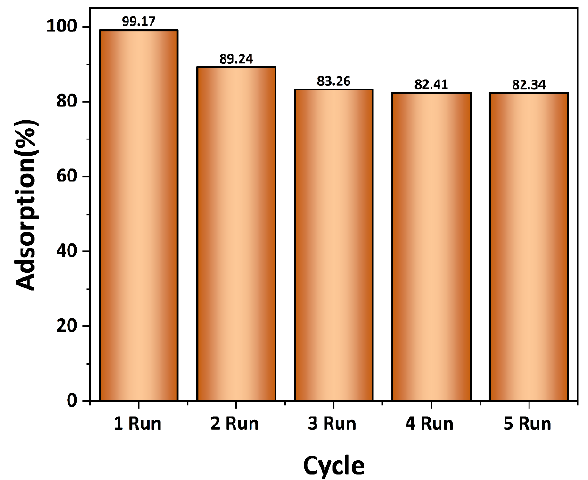
Figure 9. Reusability study of OAC − 9 on MB adsorption.